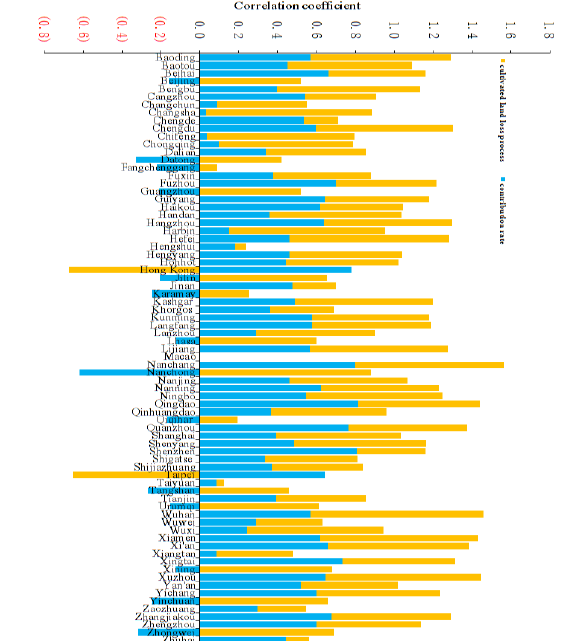
Figure 6 Correlation coefficients of cultivated land loss speed between 75 cities and the national average (in yellow bar) and cultivated land contribution to urban expansion between 75 cities and the national average (in blue